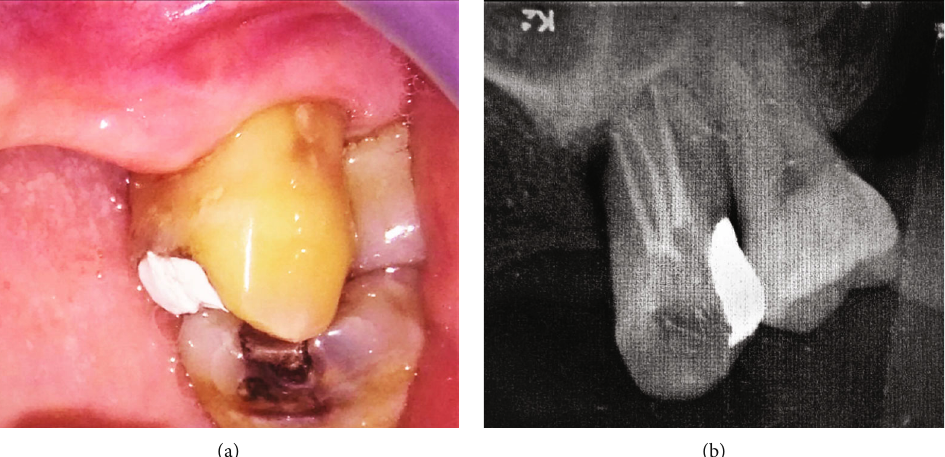
Figure 2: Clinical and radiographic examination of tooth #26 after root canal treatment. (a) Temporary fi lling covered the mesio-occlusal part of crown tooth #26. Gingiva looked normal. (b) Radiographic examination showed obturation of root canals of tooth #26 with decreased radiolucency on the apical part of the tooth.